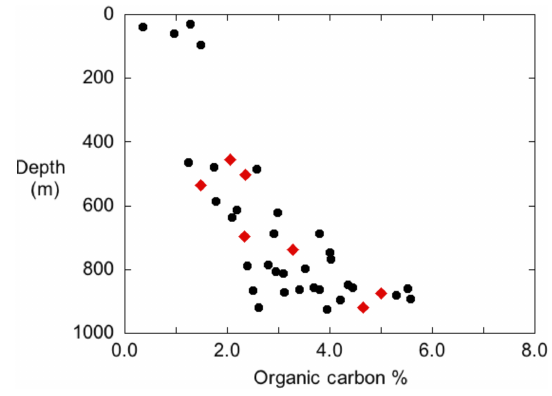
Figure 4. The %C org content for the 0–1cm intervals from MUC cores (red diamonds) and data from Gorsline (unpublished box core results). Box core data also represent the upper (0–2cm) sediment C org